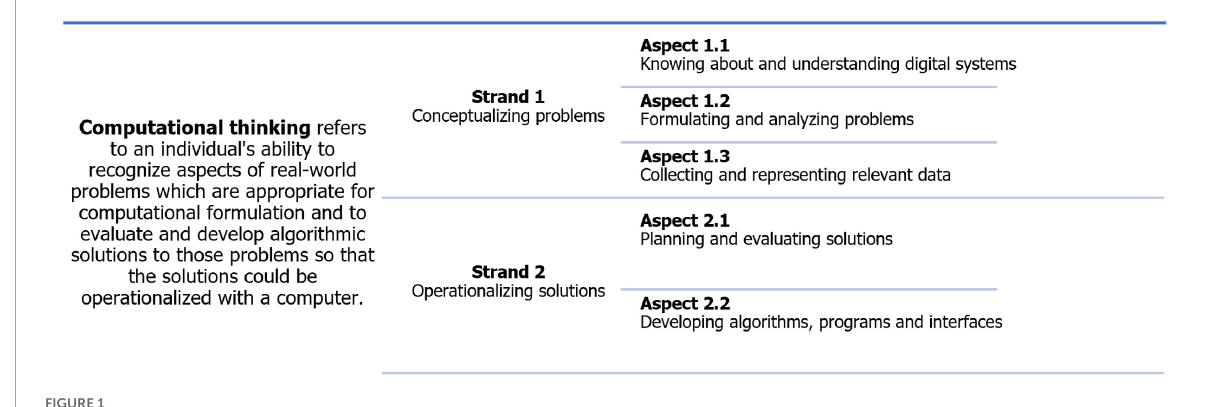
FIGURE1 The CT framework in ICILS 2018 (see Fraillon et al., 2019b, pp.